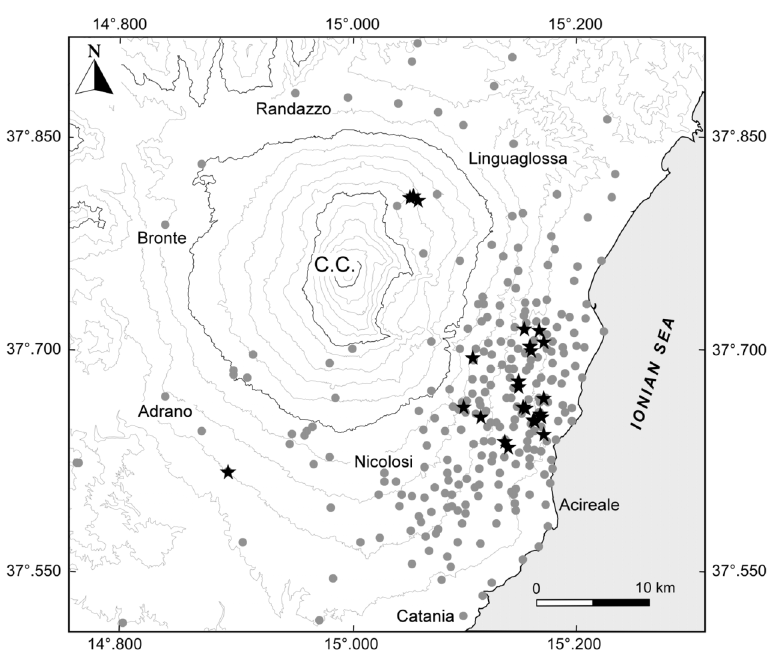
Fig. 2. Distribution of the epicentres (black stars) and related 813 site intensity observations (grey circles) of the 24 earthquakes used for the Etna region (listed in table I).